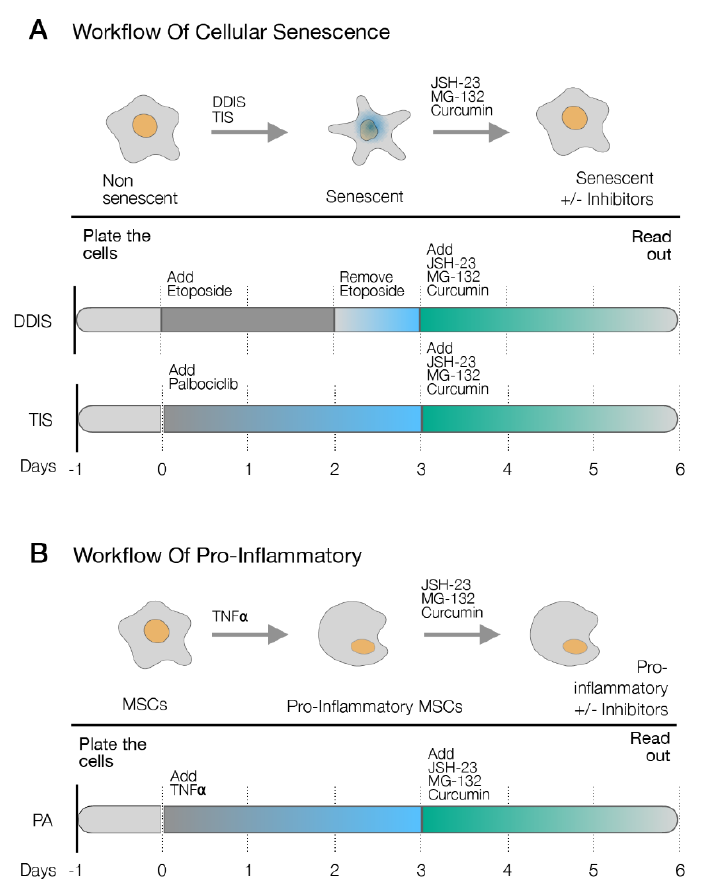
Figure 4. Schematic representation of the experimental settings to determine the role of p65 in ( A ) the cellular senescence models (DNA damage-induced senescence (DDIS) and therapy-induced senescence (TIS)) and ( B ) the proinflammatory activation (PA) in mesenchymal stem cells (MSCs) using the pharmacological inhibitors of the p65 pathway (JSH-23, MG-132 and curcumin). TNF-α: tumor necrosis factor alpha. +/−: with/without the treatment.